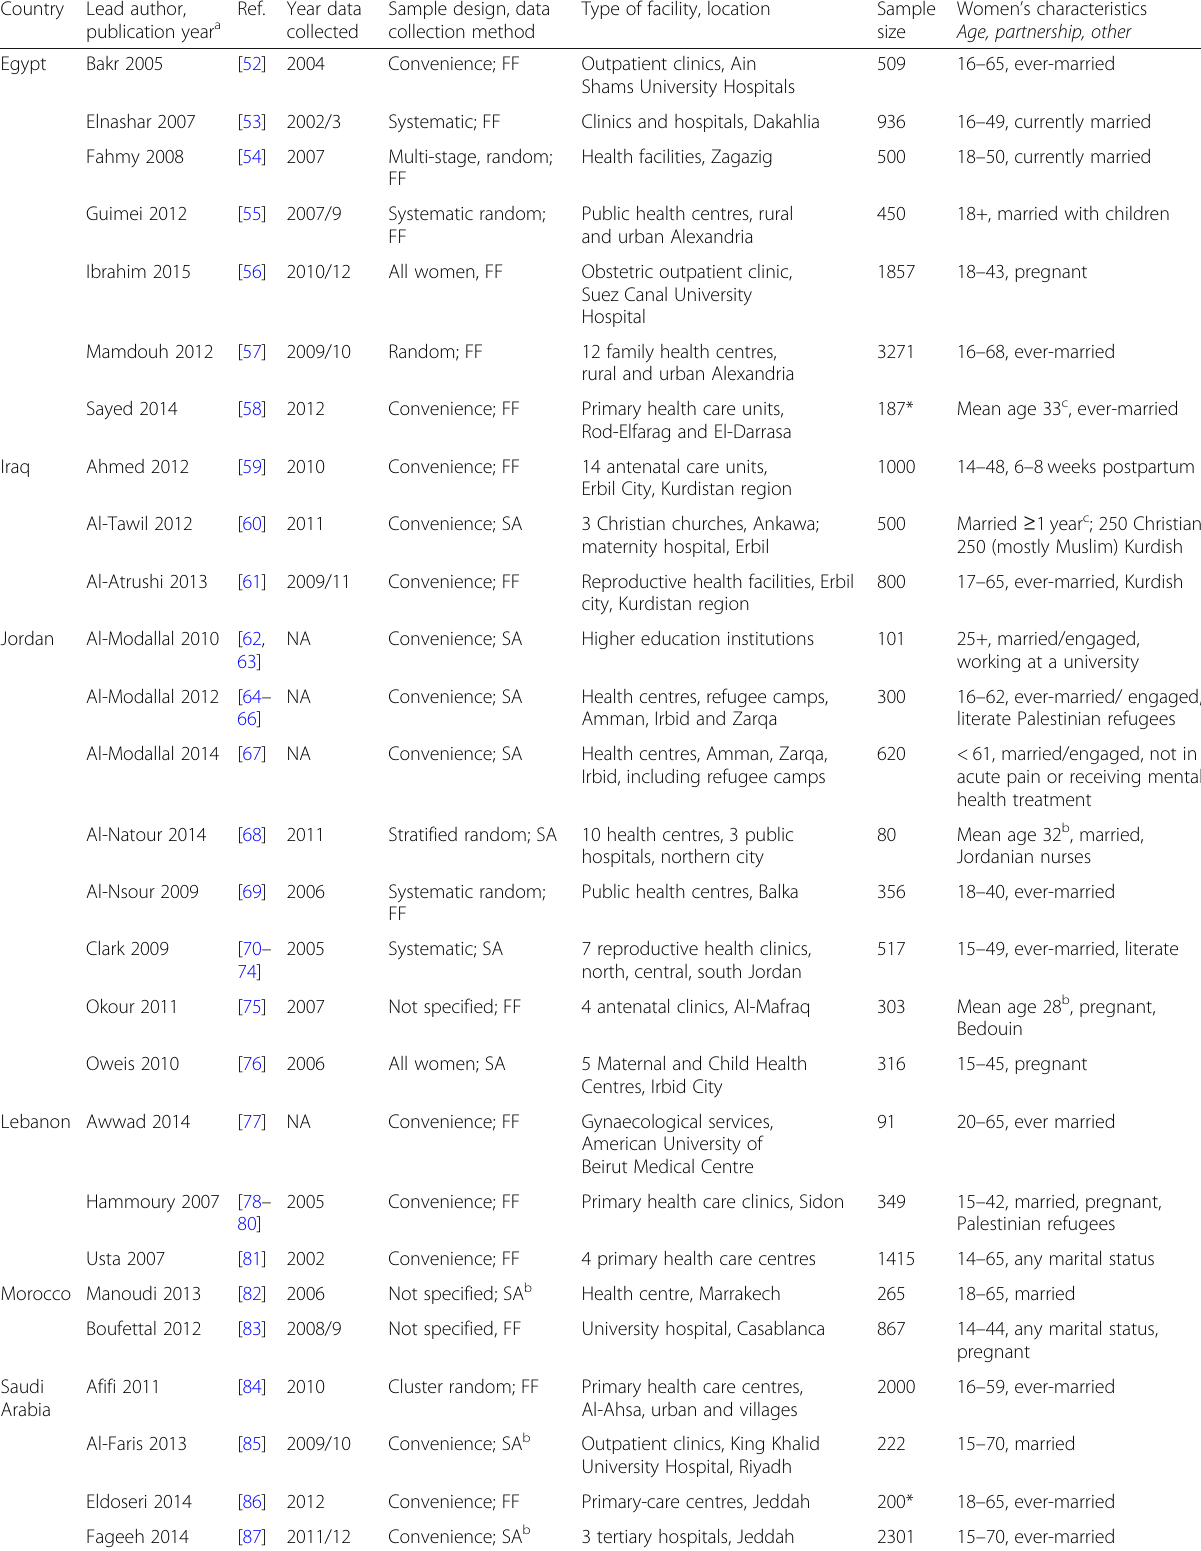
Table 3 Characteristics of facility-based IPV studies reported in peer-reviewed journal articles Country Lead author, Ref. Year data publication year a